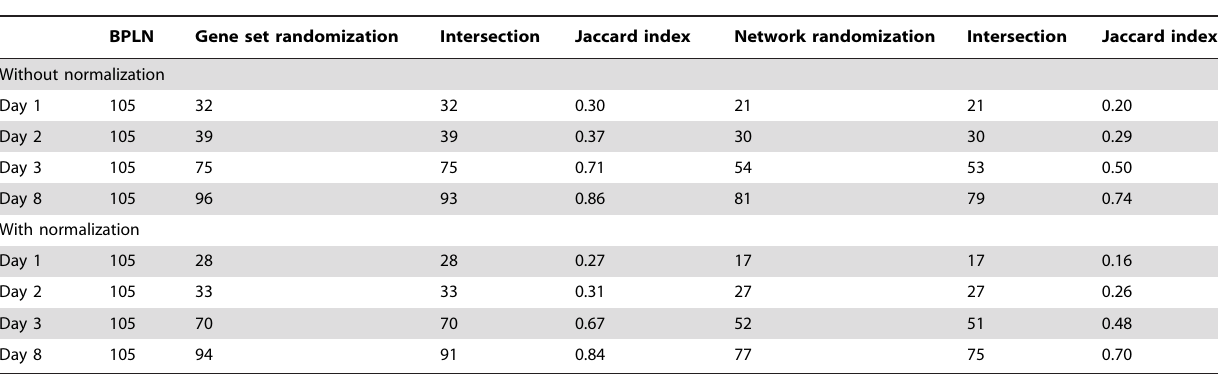
Table 4. Comparison of the number of links in the BPLN to the number of links in the CBPLNs, computed without and with